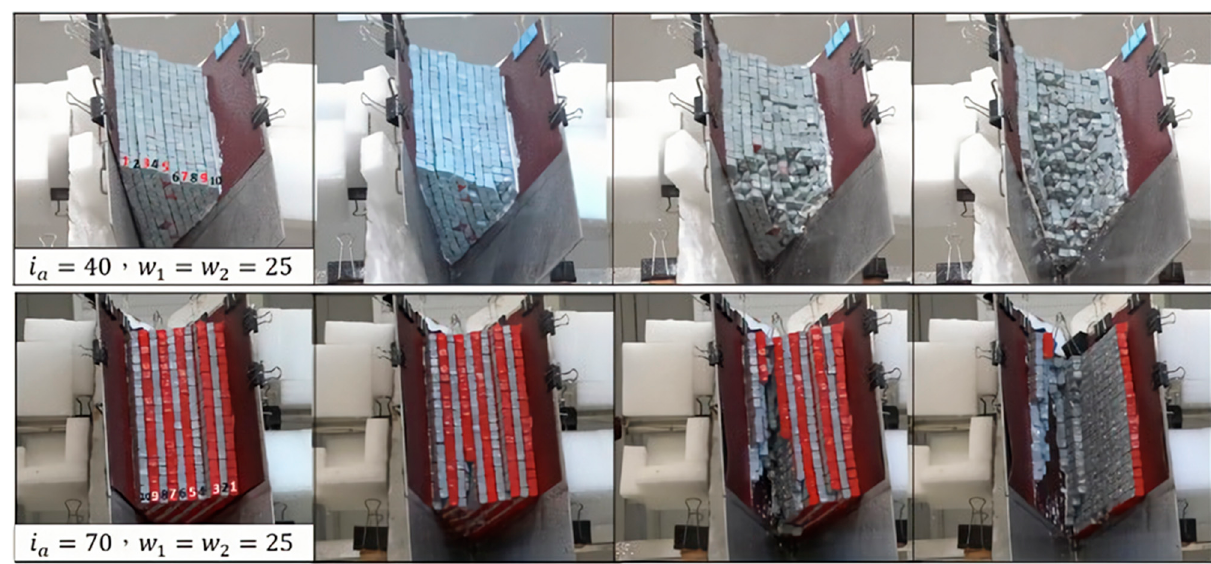
Figure 16. Comparison of tests with ω = 25° and different i a.